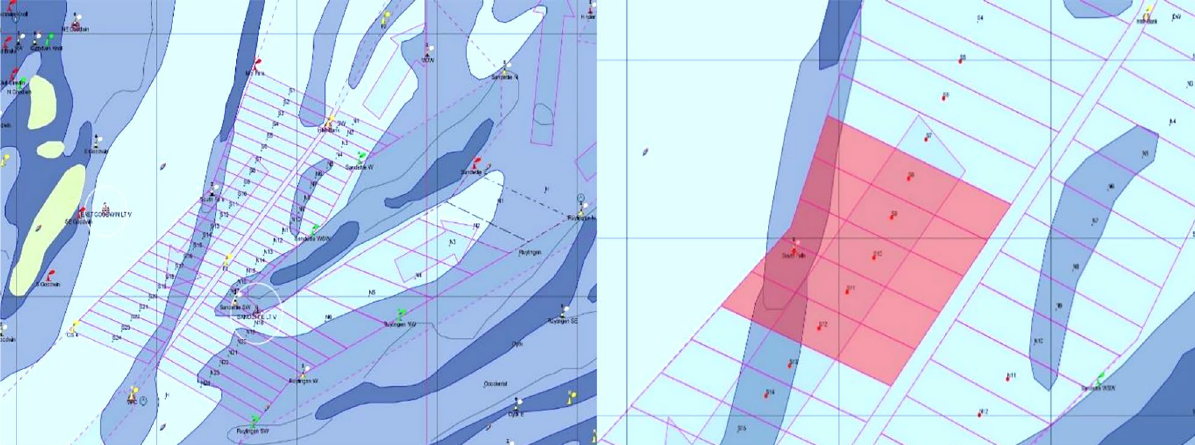
Figure 3. Dover Strait divided into zones